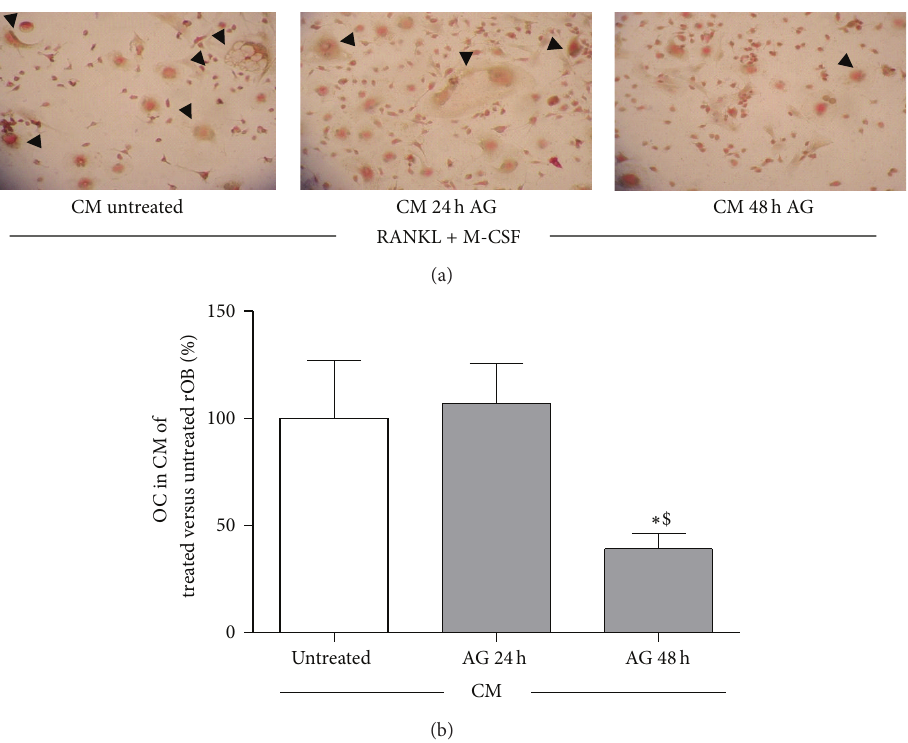
Figure 7: Effect of conditioned media (CM) obtained from rat osteoblast-like cells (rOB) treated without or with ghrelin (AG, 10 −10 M for 24 or 48 h) on osteoclast formation, in presence of 50 ng/mL RANKL and 25ng/mL M-CSF. Black arrows : multinucleated tartrate-resistant acid phosphatase positive (TRAP+) cells (a). The percentage of TRAP+ multinucleated cells ( ≥ 3 nuclei) formed after 7 days culture with conditioned media obtained from untreated and treated (AG, 10 −10 M for 24 or 48) rOB (b). ∗ 𝑃 < 0.05 versus CM of untreated cells; $ 𝑃 < 0.05 versus CM of rOB treated for 24 h with